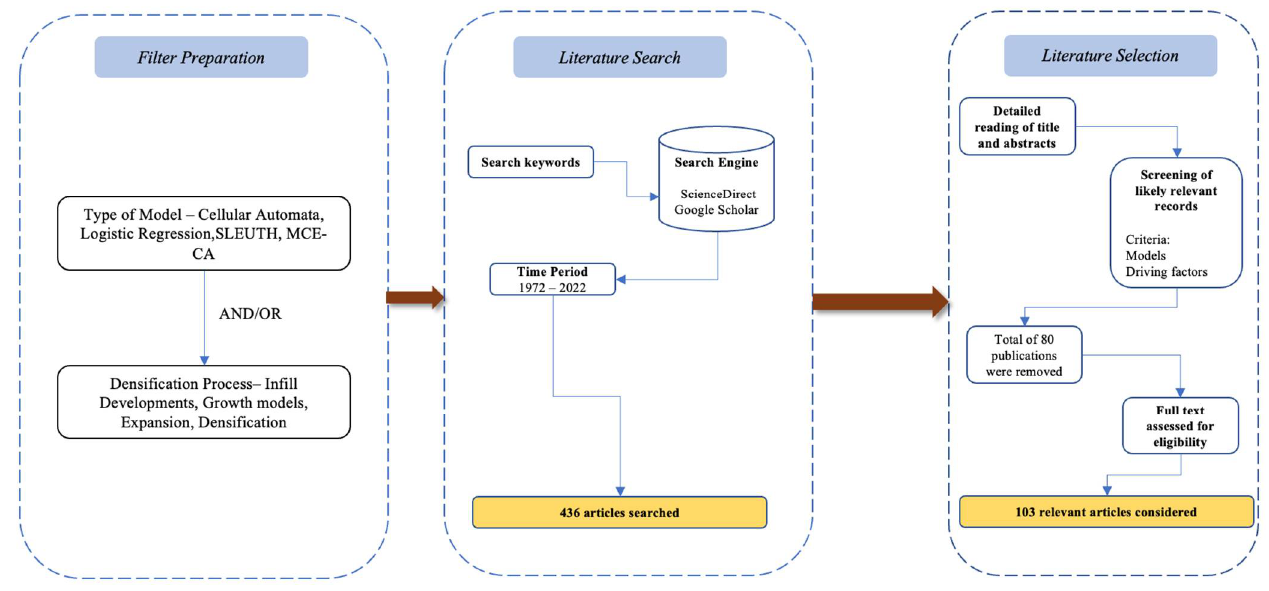
Figure 4. Methodology for literature search and evaluation.